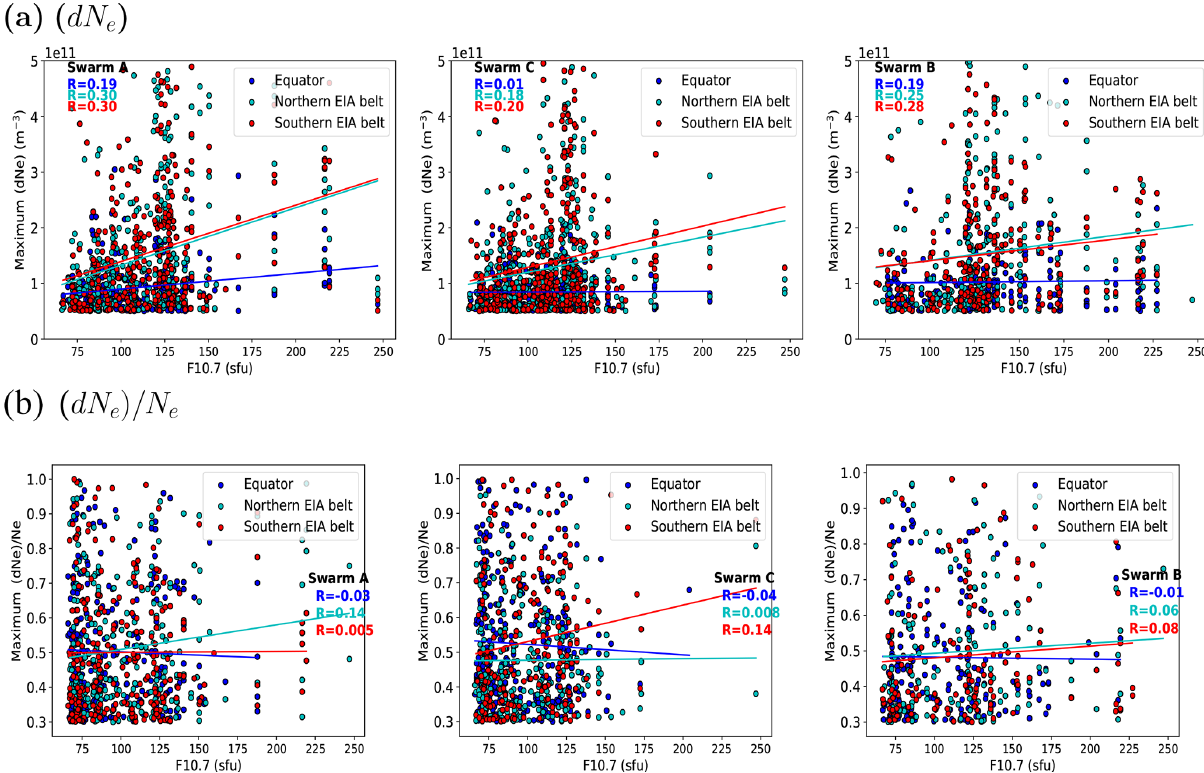
Figure 11. The distribution characteristics of (a) dN e and (b) dN e /N e with respect to 10.7cm solar radio flux in solar flux units for the period from October 2014 to October 2018. The coloured solid lines in each panel represent a linear fit to the